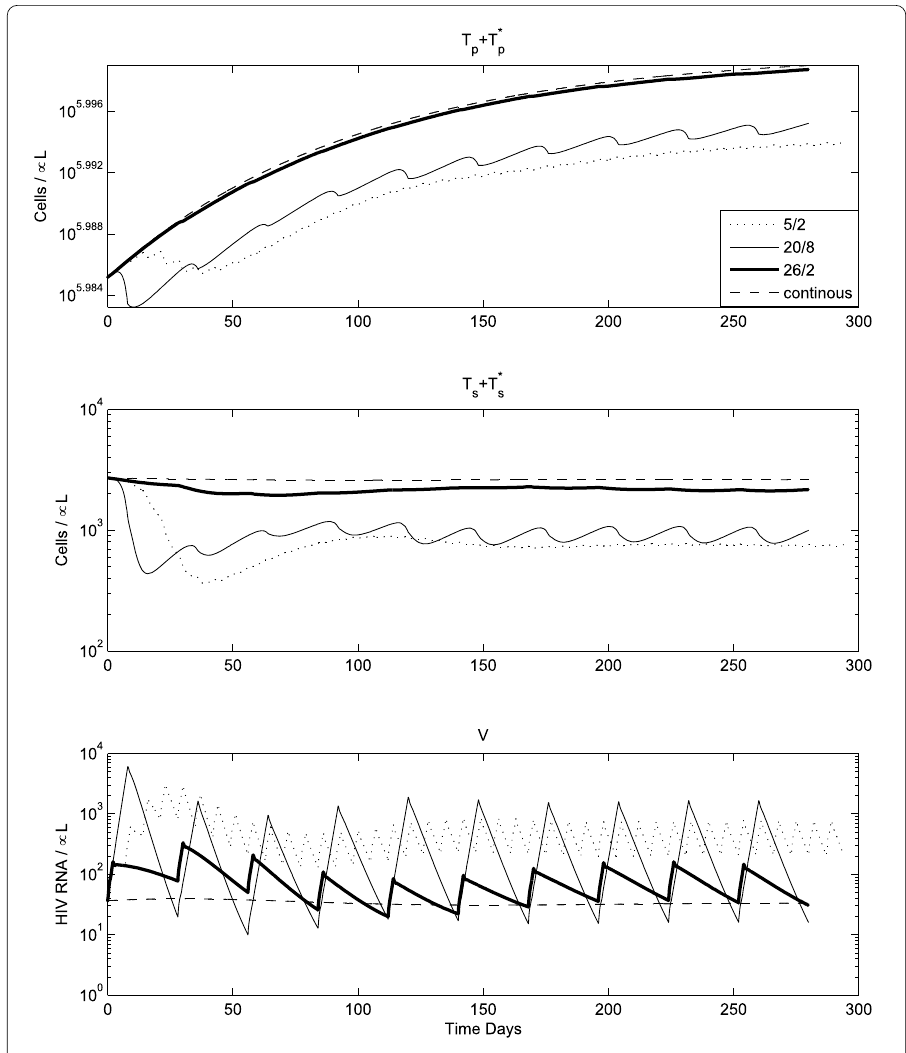
Figure 9 Correlation of the 5/2, 20/8 and 26/2 STI